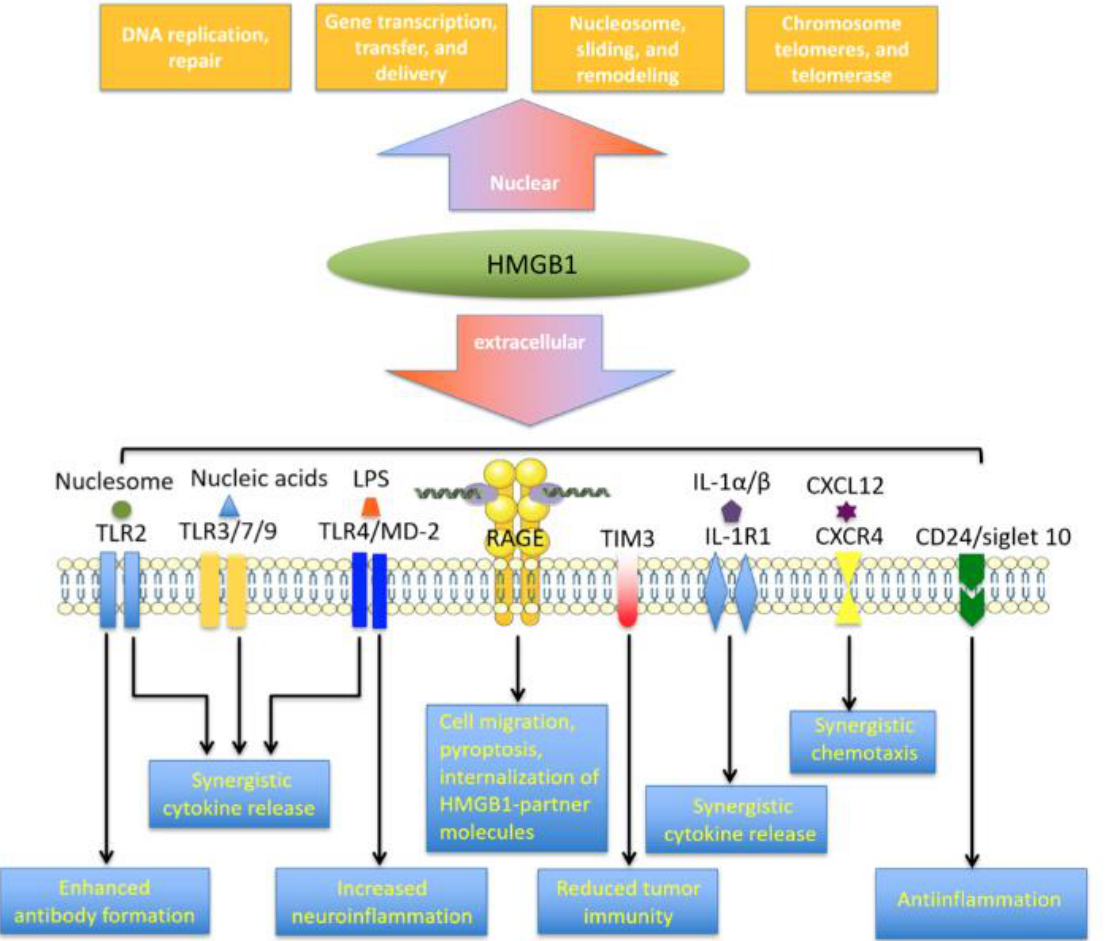
Figure 2. HMGB1 functions and associated receptor families. In the nucleus, HMGB1 functions as an architectural molecule possessing DNA-binding and -bending properties. Extracellular HMGB1, on the other hand, signals via multiple receptors such as TLR4/MD-2, TLR2, TLR3/7/9, RAGE, CD24, singlet 10, integrin/Mac1, TIM3, IL-1R1, or CXCR4. In conjunction with other mediators, HMGB1 induces cytokine release, cell migration, pyroptosis and internalization of HMGB1 binding partners; it recruits cells; it reduces inflammation and tumor immunity; it increases neuroinflammation; and it enhances autoantibody formation. Abbreviations: HMGB1, high-mobility group box 1; IL, interleukin; RAGE, receptor for advanced glycation end products; TLR, Toll-like receptor.